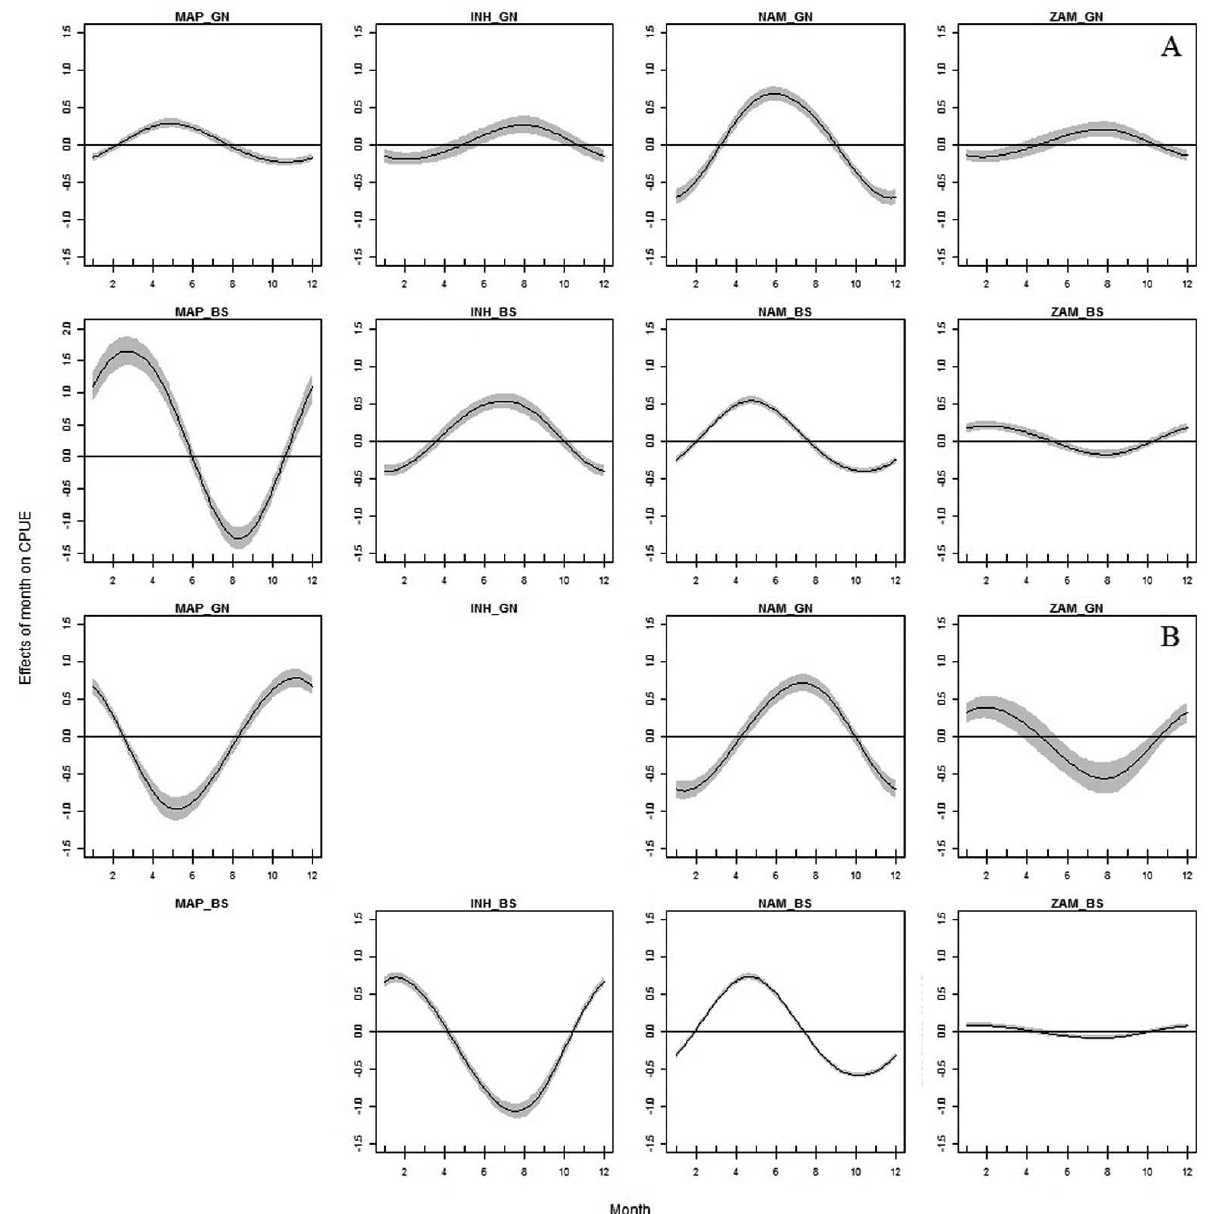
Fig. 4. – Shape of the month effect as estimated by the GAM model with the estimated 95% confidence intervals for each province and gear (see Table 3 for details); A, Hilsa kelee ; B, Tryssa vitrirostris